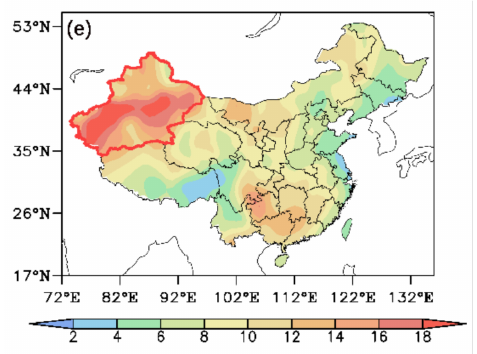
Figure 1. ( a ) The spatial distribution of winter average temperature (unit: ◦ C). ( b ) The spatial distribution of extreme low temperature threshold (unit: ◦ C). ( c ) The spatial distribution of the WPECEs occurrence frequency in China (the key area is highlighted with blue box region) (unit: times). ( d ) The spatial distribution of the WPECEs occurrence frequency in China with at least 6 consecutive days (the low temperature threshold is 10th percentile) (unit: times). ( e ) The spatial distribution of the WPECEs occurrence frequency in China with at least eight consecutive days (the low temperature threshold is 10th percentile) (unit: times). The position of Xinjiang has been marked with red bold line on the map.